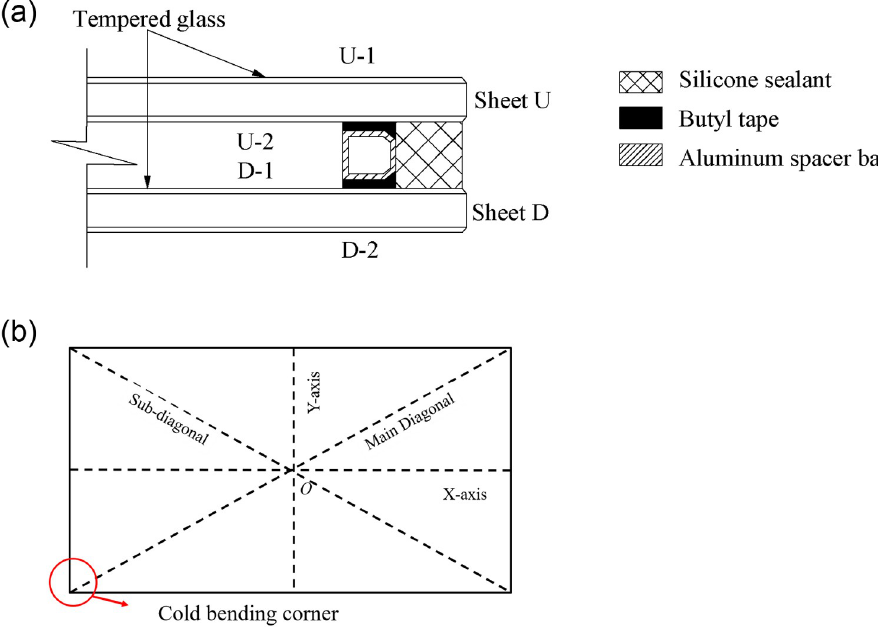
Fig 1. The nominations of the insulating glass. (a) The nominations of glass surfaces; (b) The nominations of axes and diagonals.